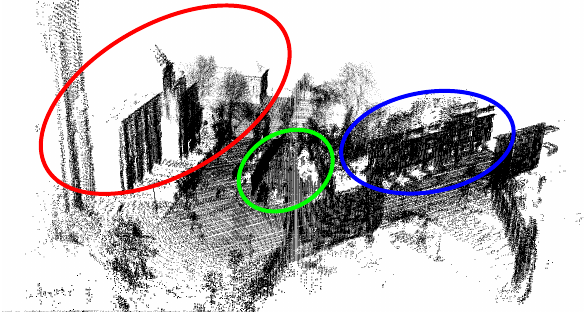
Figure 6. LiDAR point cloud of a downtown crossroads. We marked identical buildings to fig. 7 by ellipses of same color. cloud, cf. fig. 7 (bottom). The cropped landscape model con- sists of almost 50 000 points and has a ground resolution of only 0.55 m per pixel. Originally, a digital surface model (2.5d) has been produced, which we transformed into a 3d point cloud. The reconstructed mesh shows only the roofs and the road surfaces, but it lacks of building facades. Furthermore, the accuracy of the height values is very low, e.g., the church tower is missing in the data.